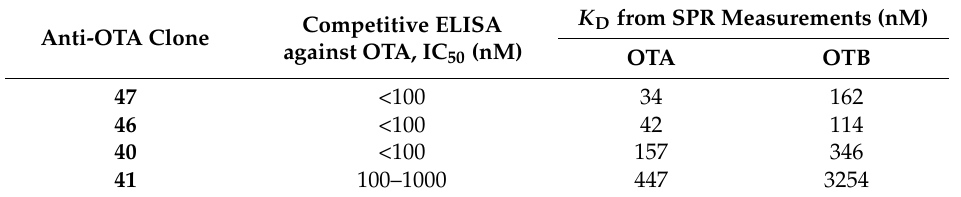
Table 5. Affinities and specificities of the anti-OTA antibodies measured by competitive ELISA and SPR.